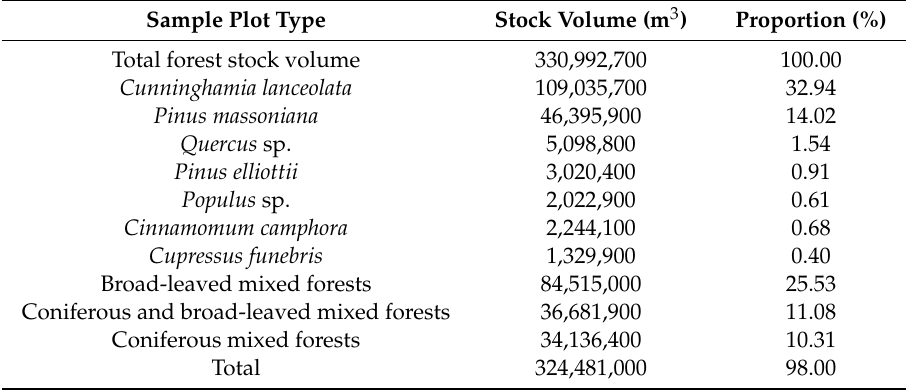
Table 1. The proportion of the FSV from the ten forest types in Hunan Province, China. Sample Plot Type